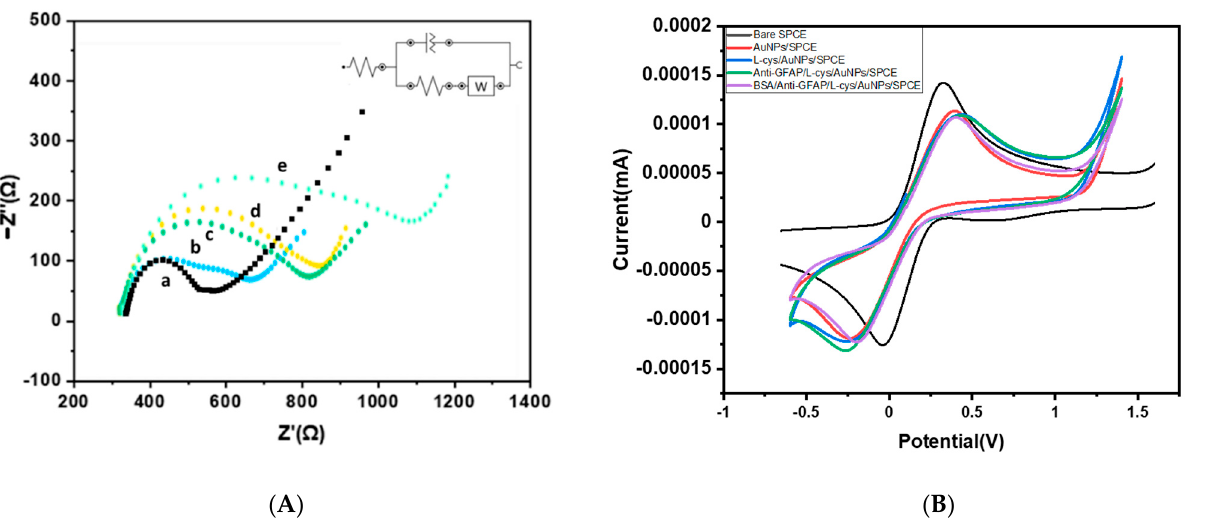
Figure 1. The Nyquist diagrams ( A ) showing GFAP immunosensors, step-by-step (a: Bare SPCE; b: AuNPs/SPCE; c: L-cys/AuNPs/SPCE;d: Anti-GFAP/L-cys/AuNPs/SPCE; e: BSA/Anti-GFAP/L- cys/AuNPs/SPCE) and cyclic voltammograms ( B ).